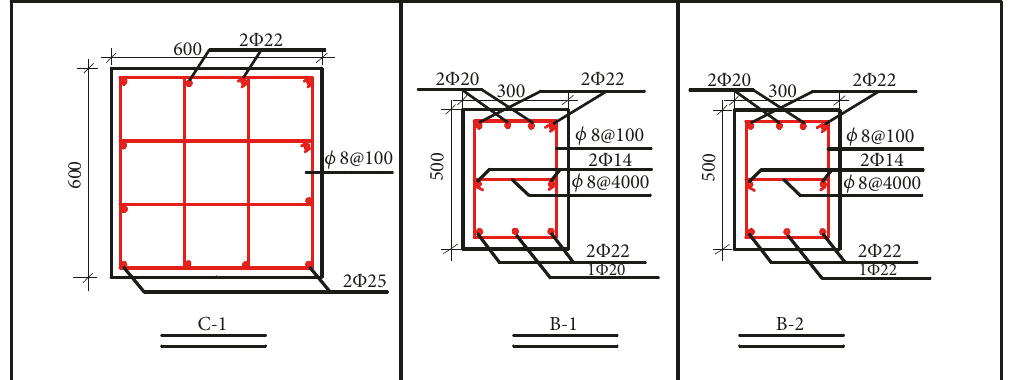
Figure 3: The distributed steel in columns and beams.